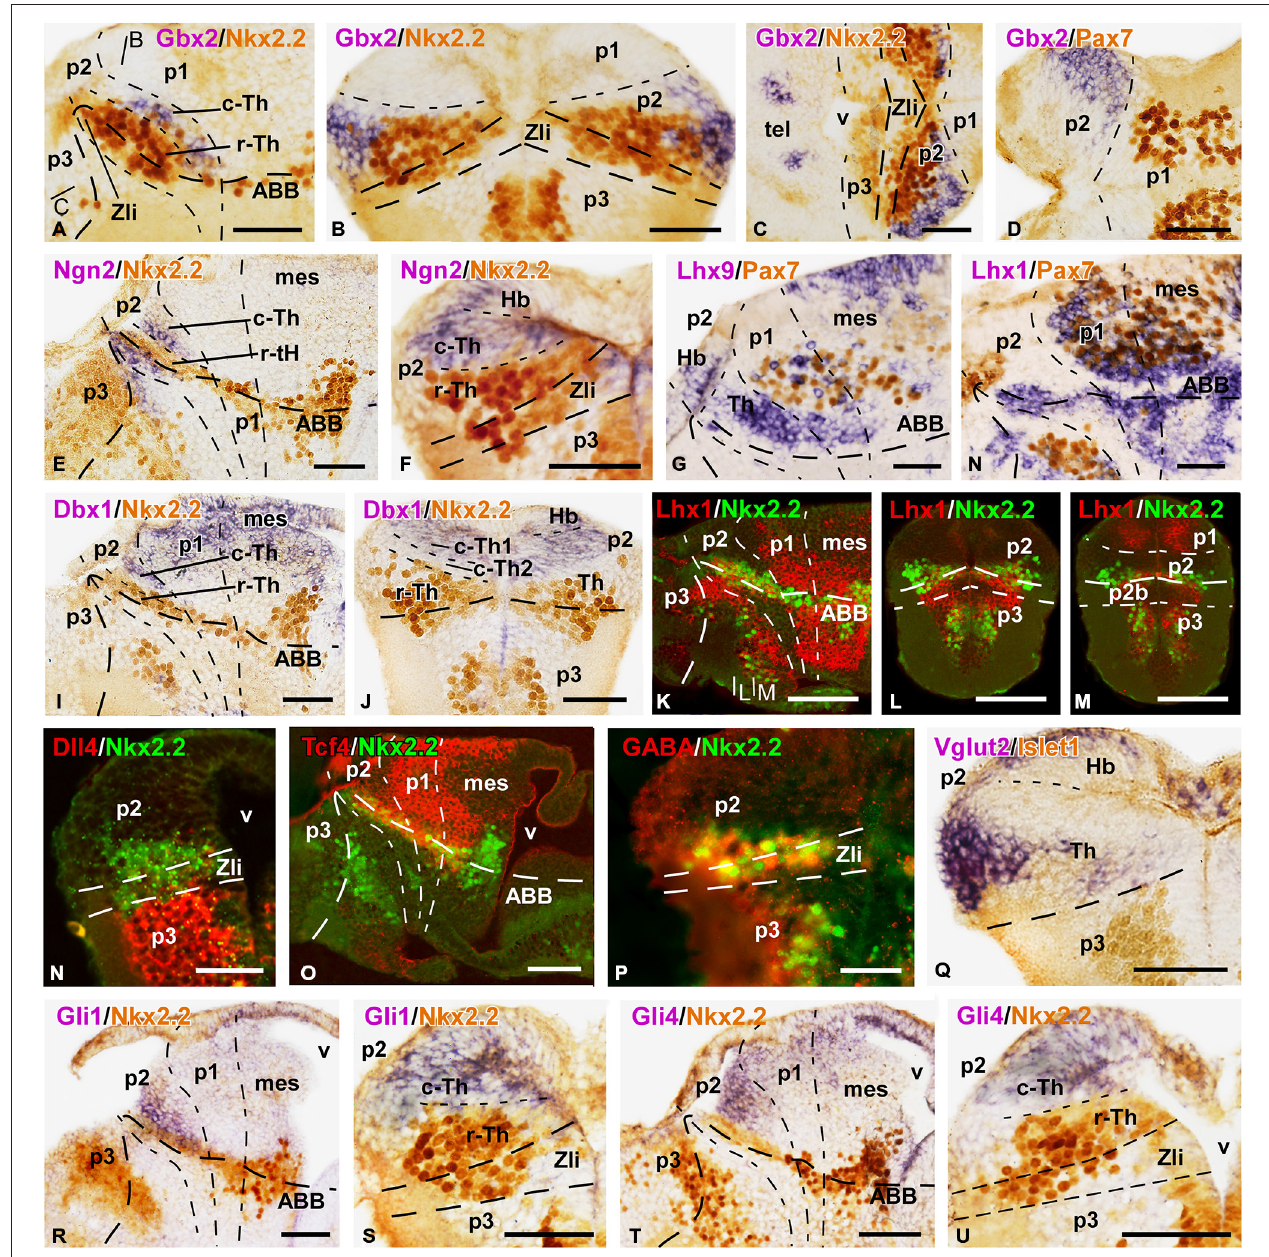
oriented following the same standard: dorsal is upwards in transverse and sagittal sections, and rostral is to the left in sagittal sections; in the horizontal sections rostral is to the left. The neuromeric boundaries and main brain subdivisions are indicated to assist in the precise localization of the labeling. The levels of the transverse section (B) is indicated in photograph (A) , and the levels of (L,M) are indicated in (K) . Scale bars = 100 µ m (K–M,O) , 50 µ m (A–J,N,P–U) . See list for